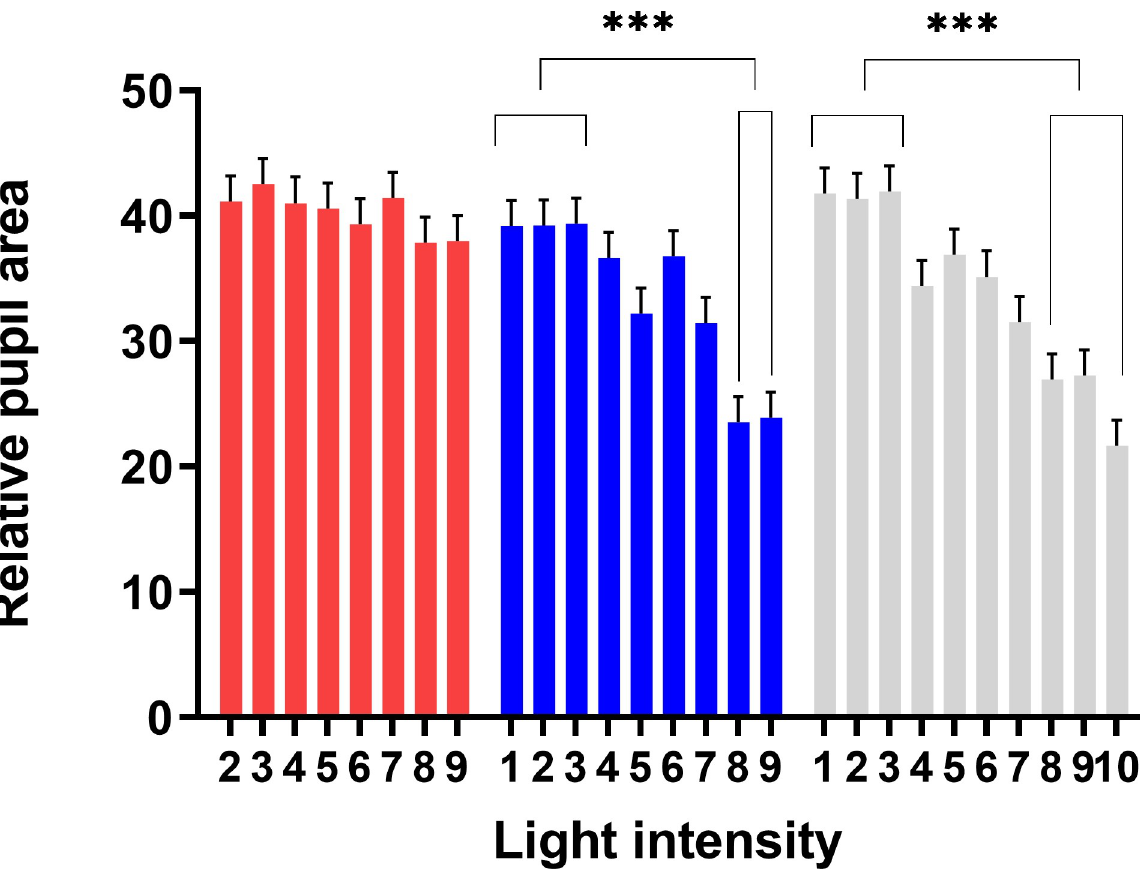
Fig 5. Relative area of the pupil (RAP) of cows exposed to Red, Blue, and White light intensity. There was no difference in relative pupil area for cows under red light. Under blue and white light, the relative pupil area decreased by almost half ( ��� p <